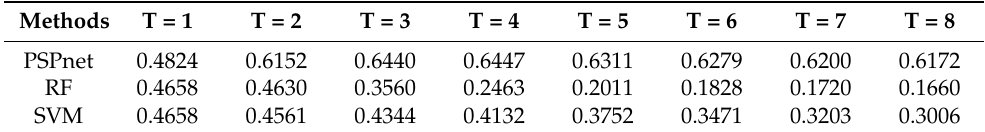
Table A2. The IoU of sample size S = 40 varies with the threshold level T.